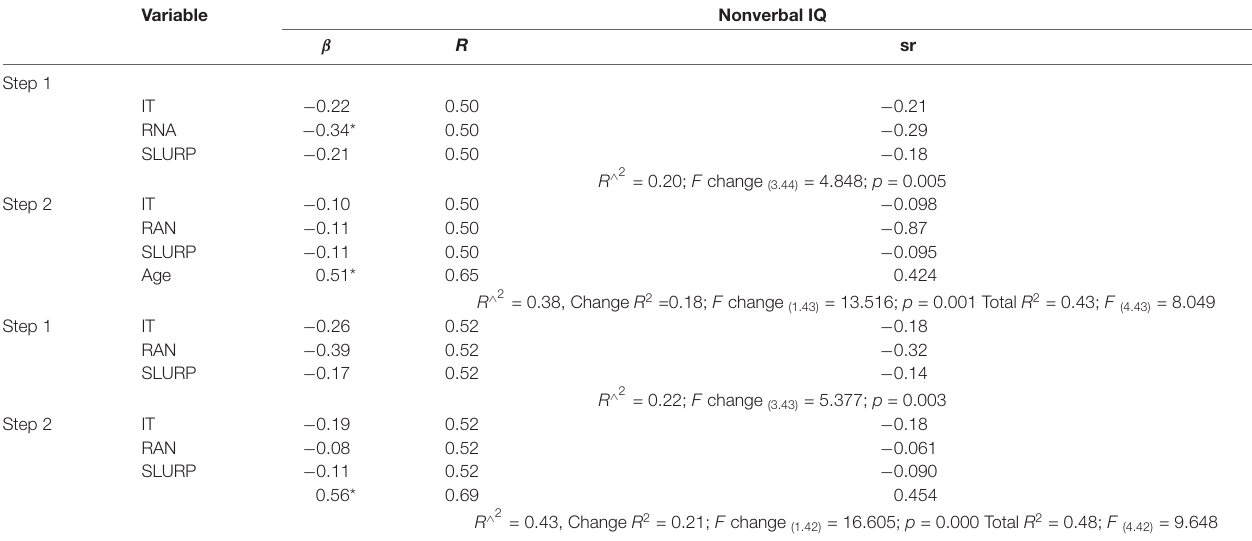
TABLE 4 | Predictive contribution of visual, visual-verbal processing, and visuomotor skills, age and MAS on nonverbal IQ.